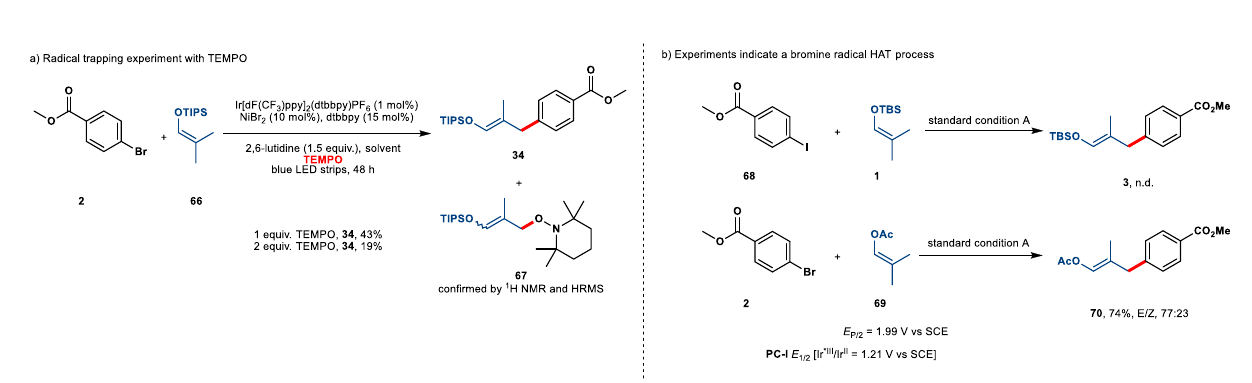
Fig. 5 | Preliminary mechanistic studies. a Radical trap experiment. b Mechanistic hints from using either vinyl acetate or aryl iodide as coupling